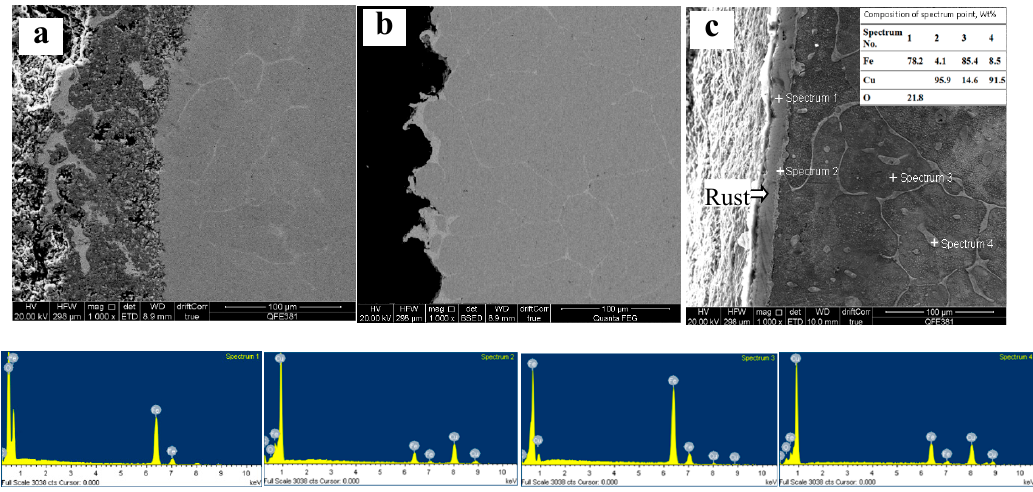
Figure 2. Scanning electron microscope (SEM) (BSE) morphologies on the cross section of steel 2 after being heated at 1000 °C ( a ), 1100 °C ( b ) and 1150 °C ( c ) for 2 h, and EDX results of corresponding points in ( c ).